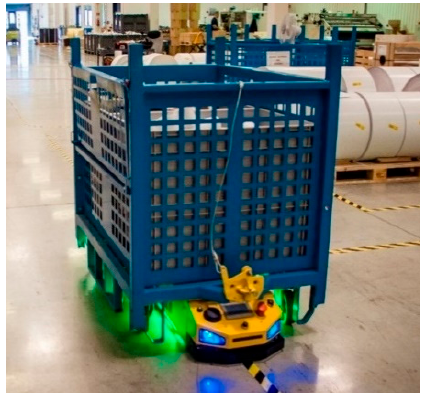
Figure 1. Tractor-type AGV Pull500 manufactured by Etisoft Smart Solutions Sp. z o.o.